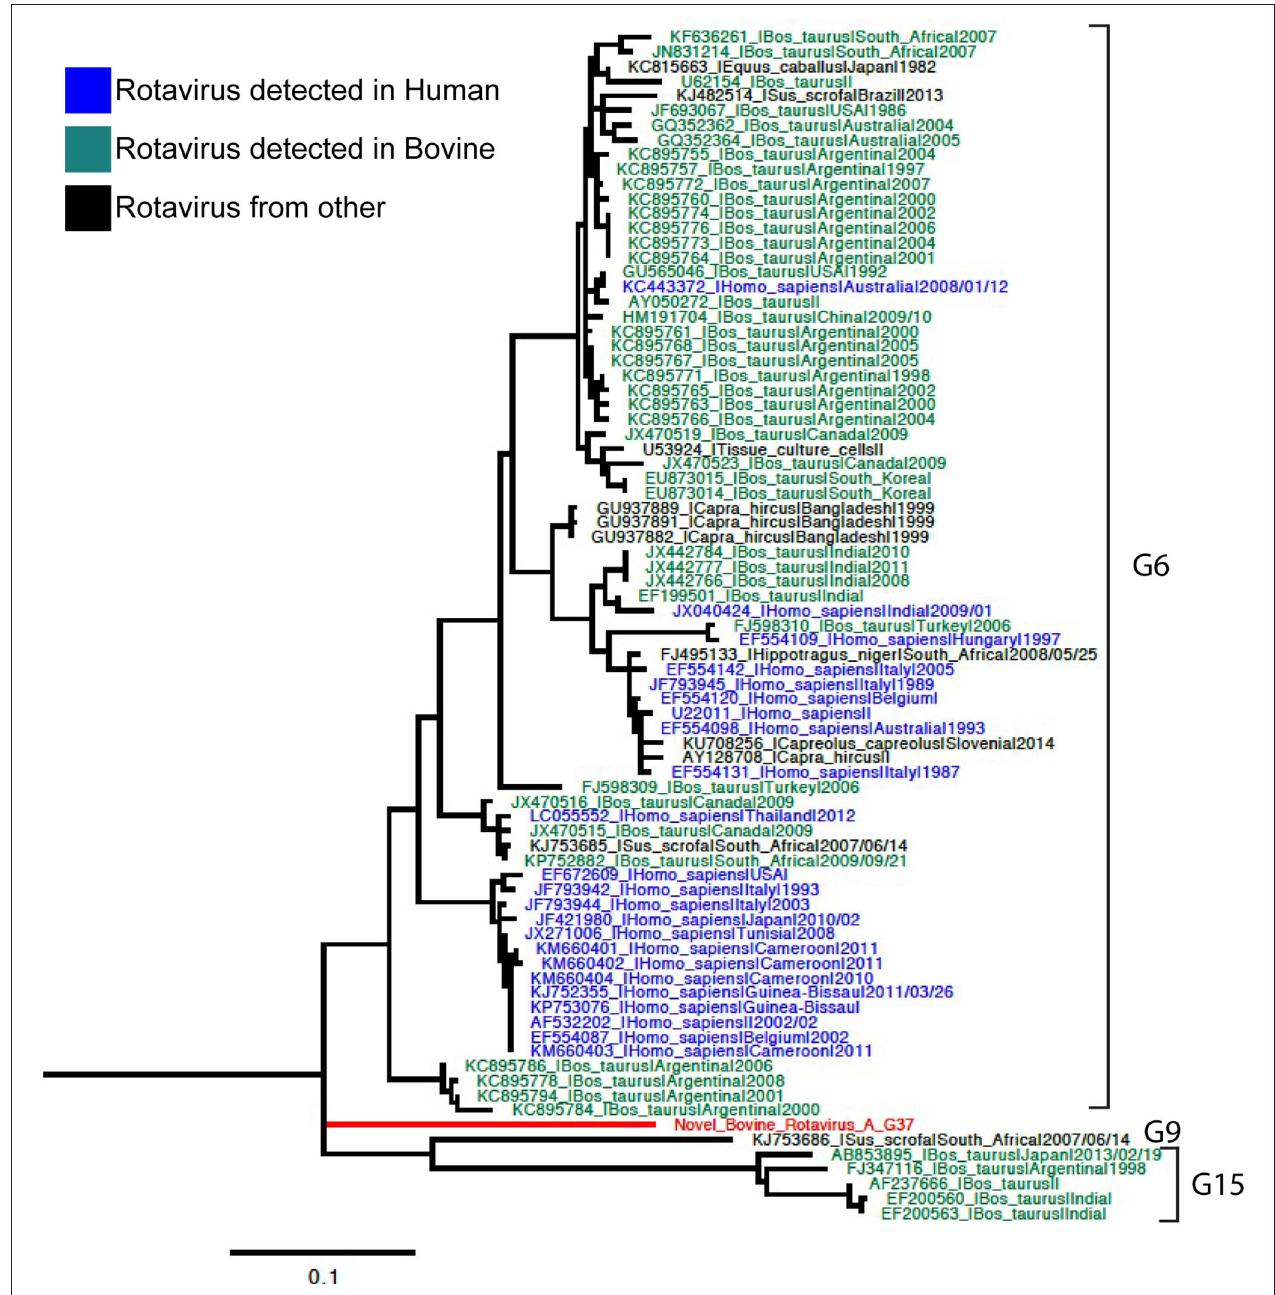
FIGURE 1 | Phylogenetic tree of VP7 rotavirus A (RVA) segment using ML GTR + R 1,000 replicates. Reference sequences are depicted in blue for human origin rotaviruses, green for bovine origin rotaviruses, and orange for swine origin rotaviruses. Novel rotavirus sequence is depicted in red.